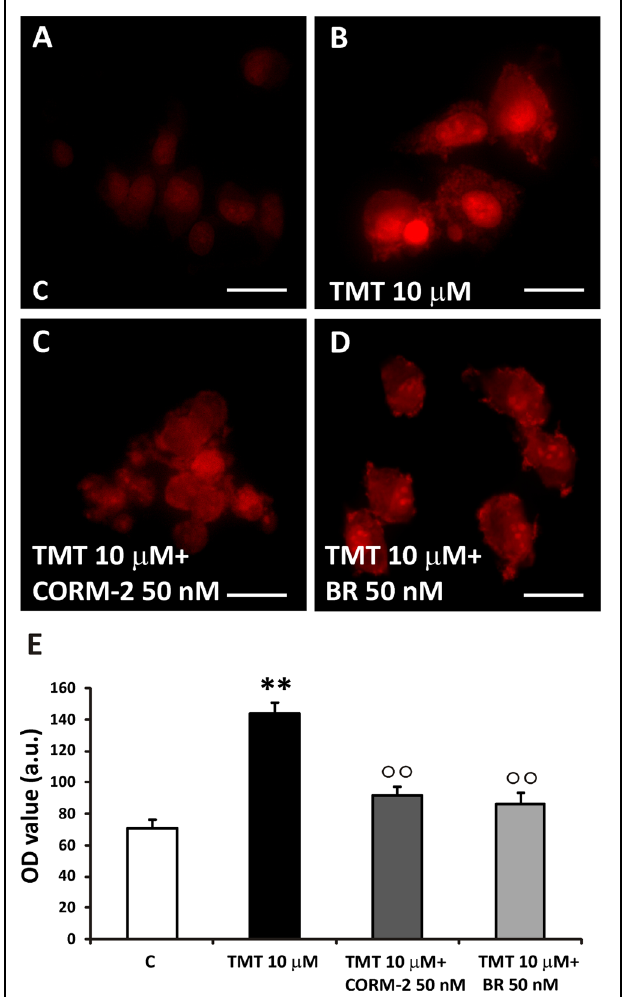
FIGURE 8 | TMT-induced superoxide production. (A–D) Representative immunofluorescence images of SH-SY5Y cells treated with TMT (10 μ M), CORM-2 (50 nM) and bilirubin (BR, 50 nM) and stained with DHE. In control cells, DHE staining was faint (A) . TMT (10 μ M) induces a great increase in superoxide production, as indicated by the rise of red fluorescence (B) . When cells are treated with TMT (10 μ M) + CORM-2 (50 nM; C) or TMT (10 μ m) + BR (50 nM; D) , ROS production significantly decreases with respect to TMT alone. In (E) , a bar graph (mean ± SEM) showing fluorescence signal quantification in treated cells for 4-HNE labeling. Data are representative of three independent experiments performed on five field selected randomly. Scale bar: 20 μ m. Magnification: 40 × . For further information see text. ∗∗ P < 0.01 vs. controls (C) , ◦◦ P < 0.01 vs.